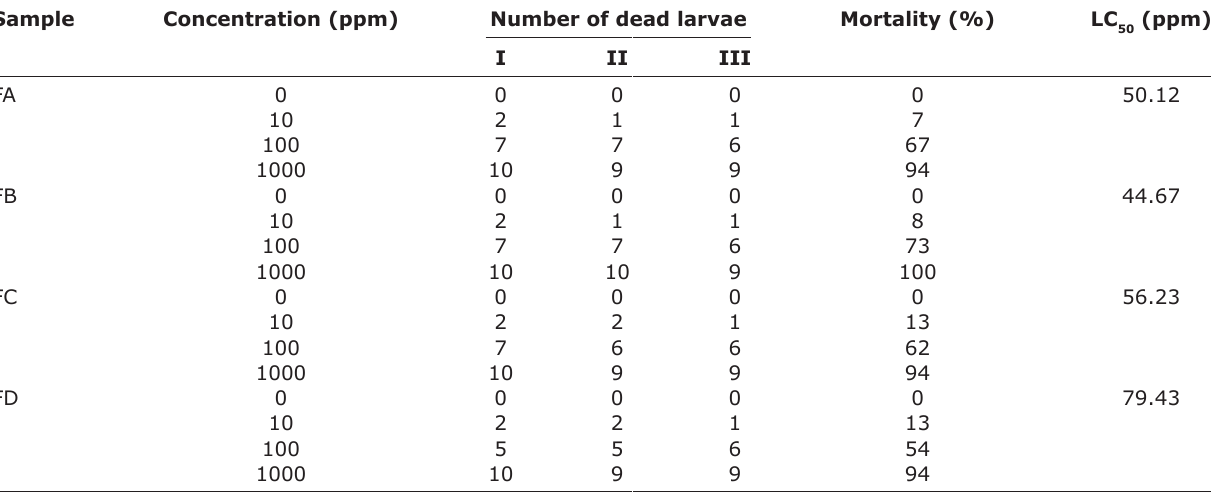
Table-2: The toxicity of the fraction results from column chromatography. Sample Concentration (ppm)